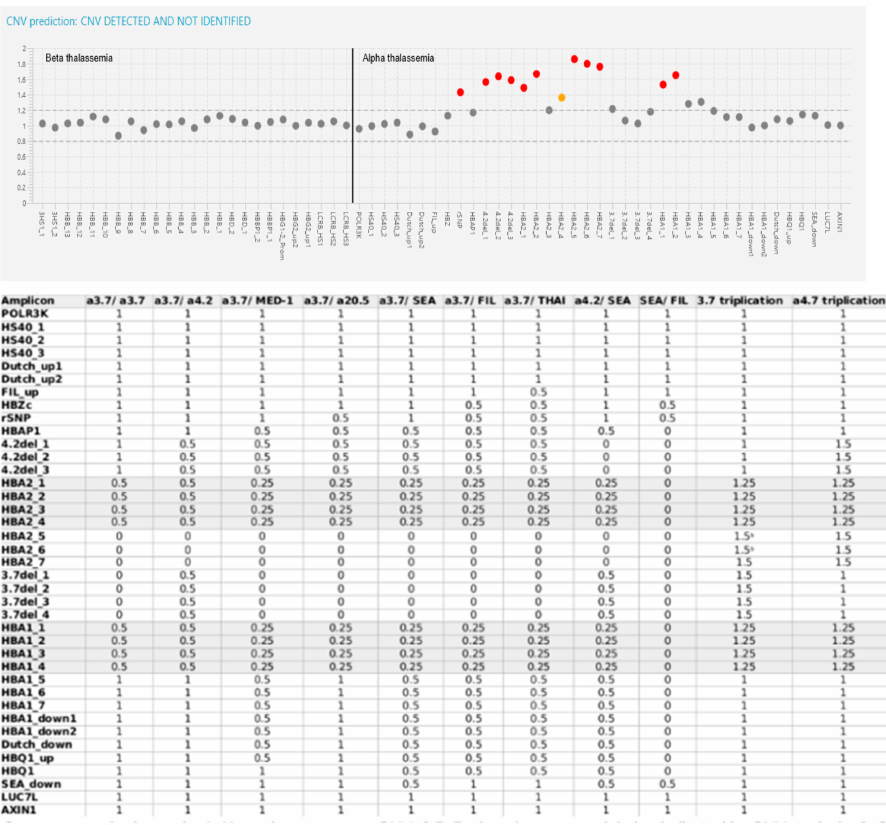
Figure 3. Case 12 was a case of 4.2 triplication detected by the DEVYSER Software. The table below is the expected coverage in the CNV analysis for amplicons involving HBA gene complex duplications/triplications. A 1.5 was indicative of duplication indicated by CNV analysis. (Red dot indicates CNV less than or equal to 0.60 or greater than or equal to 1.66, while orange dot indicates, CNV between 0.60 and 0.7 and between 1.50 and 1.66